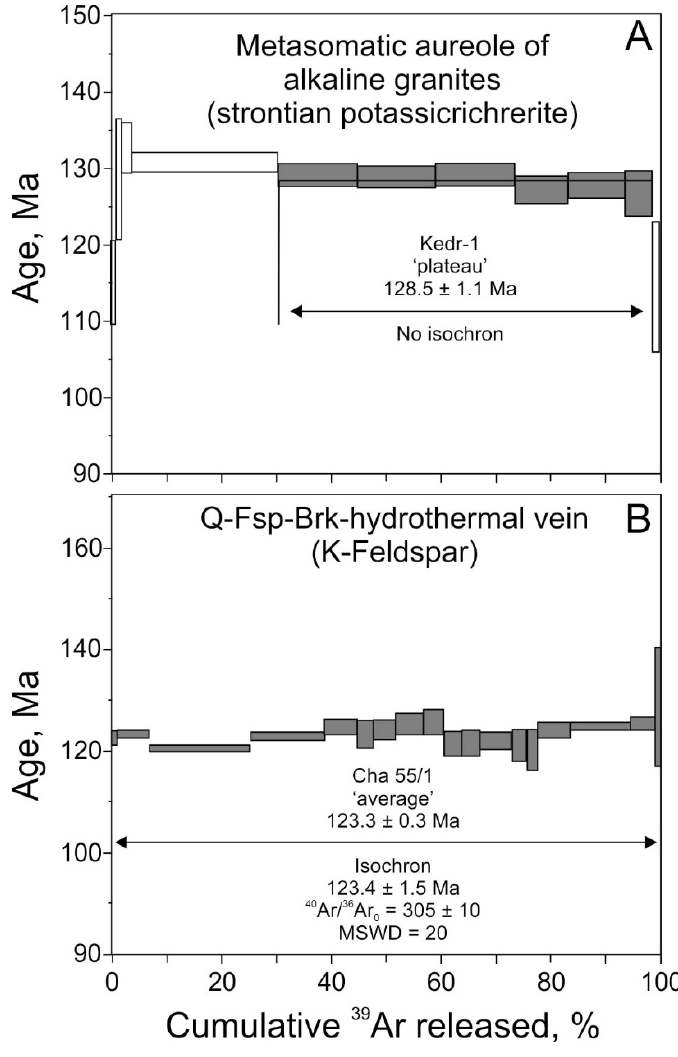
Figure 8. Argon release spectra for metasomatic and hydrothermal minerals: ( A ) Sample Kedr-1—strontian potassicrichrerite (K[(Ca,Sr)Na][Mg 5 ]Si 8 O 22 (OH) 2 ) in a contact zone of alkaline granite intrusion; ( B ) sample Cha55/1—K-feldspar from a quartz-feldspar-brookite hydrothermal vein. Steps used for calculation of plateau, average, and isochron age values are shadowed.